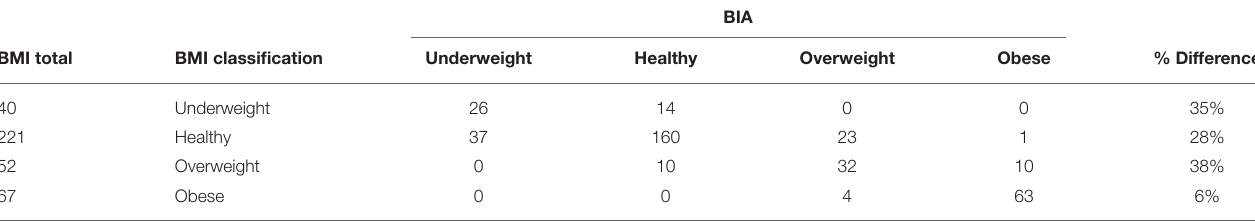
TABLE 3 | Classification differences between BMI and BIA by all